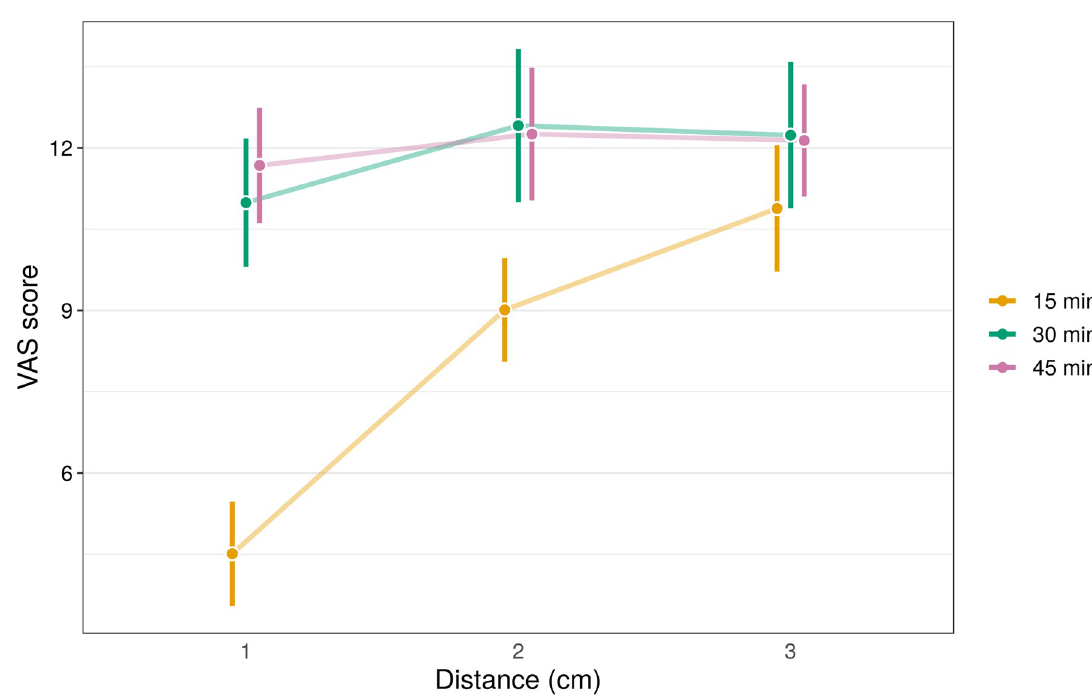
Fig 6. The multi-line chart demonstrates mean estimates of VAS scores with 95% confidence intervals for pain experienced by subjects due to the superficial pin-pricks with 27 G needle for three different time points at 15, 30 and 45 minutes after the lidocaine injection with MicronJet600, and at 1, 2 and 3 centimeters from the injection